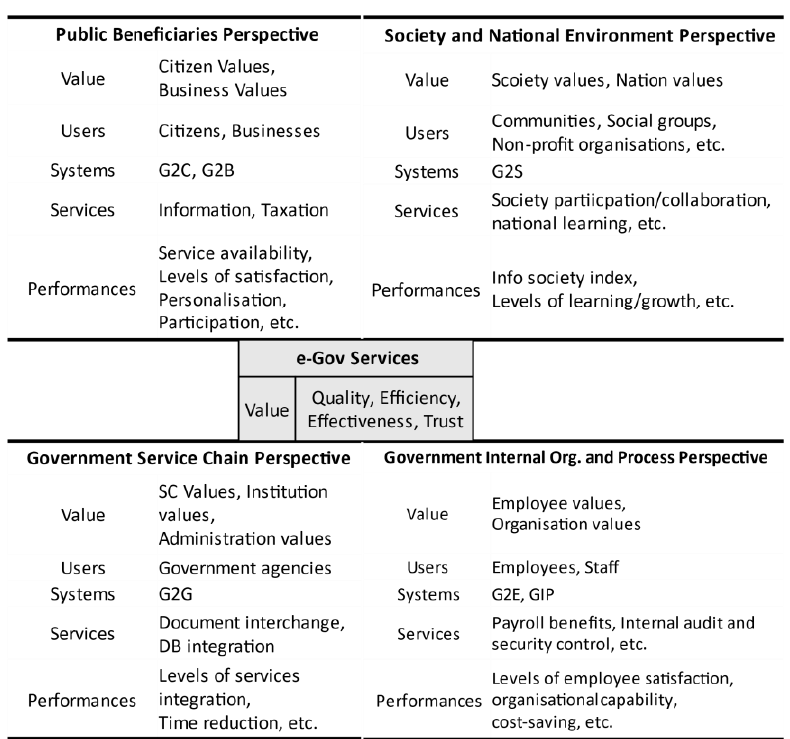
Figure 2: Value-centric framework by Yu (2008, p.